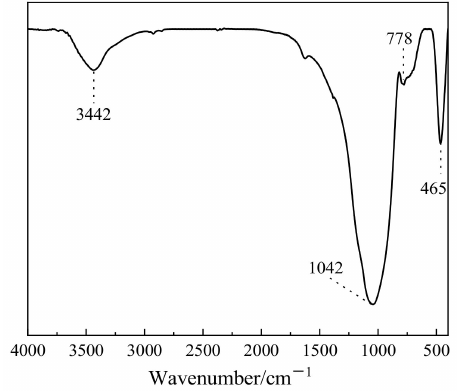
Figure 6. FTIR spectrum of the GFS